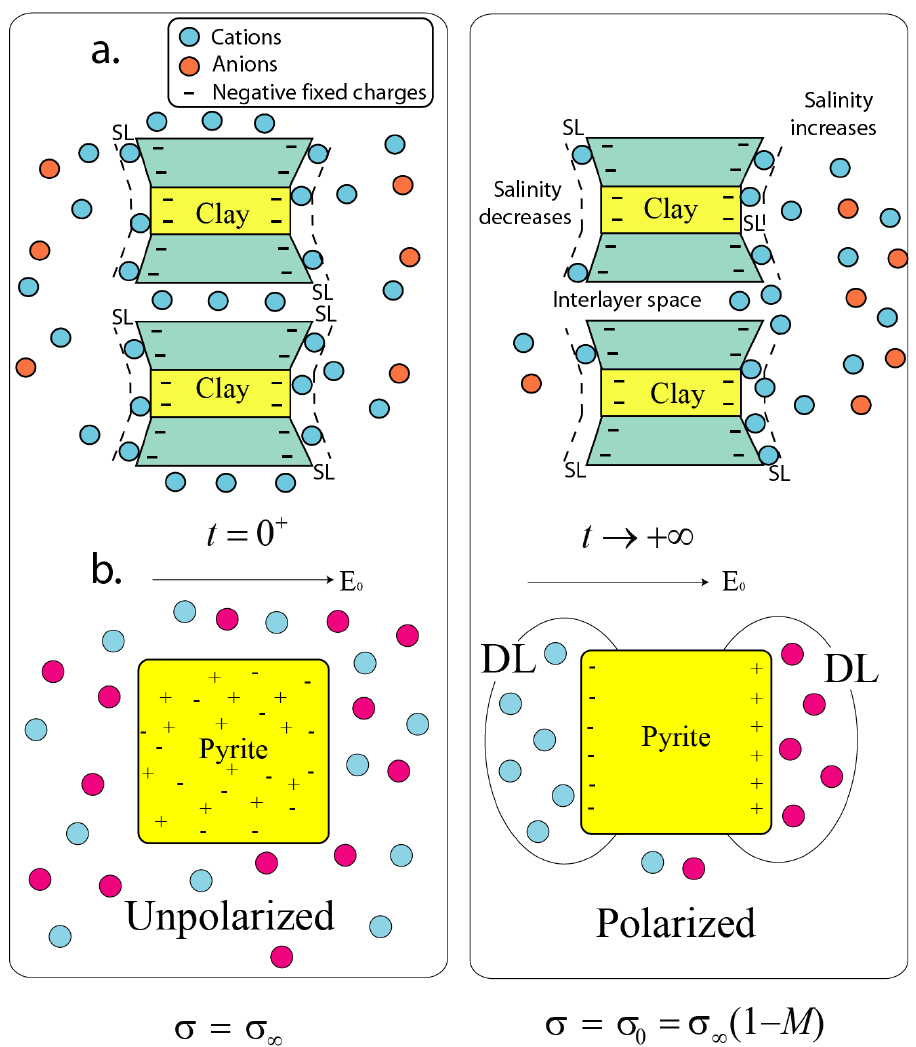
Figure 5. Induced polarization of metallic and nonmetallic grains. ( a ) Nonmetallic grains such as clays are characterized by an electrical double layer that coats their surface. Under the influence of an external electrical field ( E 0 ), the polarization of this electrical double layer provides a dipole moment to the grain. The main mechanism of polarization is the polarization of the Stern layer (SL), which is the inner part of the electrical double layer. ( b ) Polarization of a pyrite cube. The electro-diffusion of the charge carriers inside the grain (electrons and p-holes) polarizes the grain, which provides a dipole moment to the grain. A second polarization component is associated with field-induced diffuse layers (DL) in the electrolyte at the solid – liquid interface. The left-hand-side figures define the instantaneous (high-frequency) conductivity for the nonmetallic and metallic grains, while the right-hand-side figures define the DC (direct current, low-frequency) conductivity that corresponds to a long application of the electrical field.